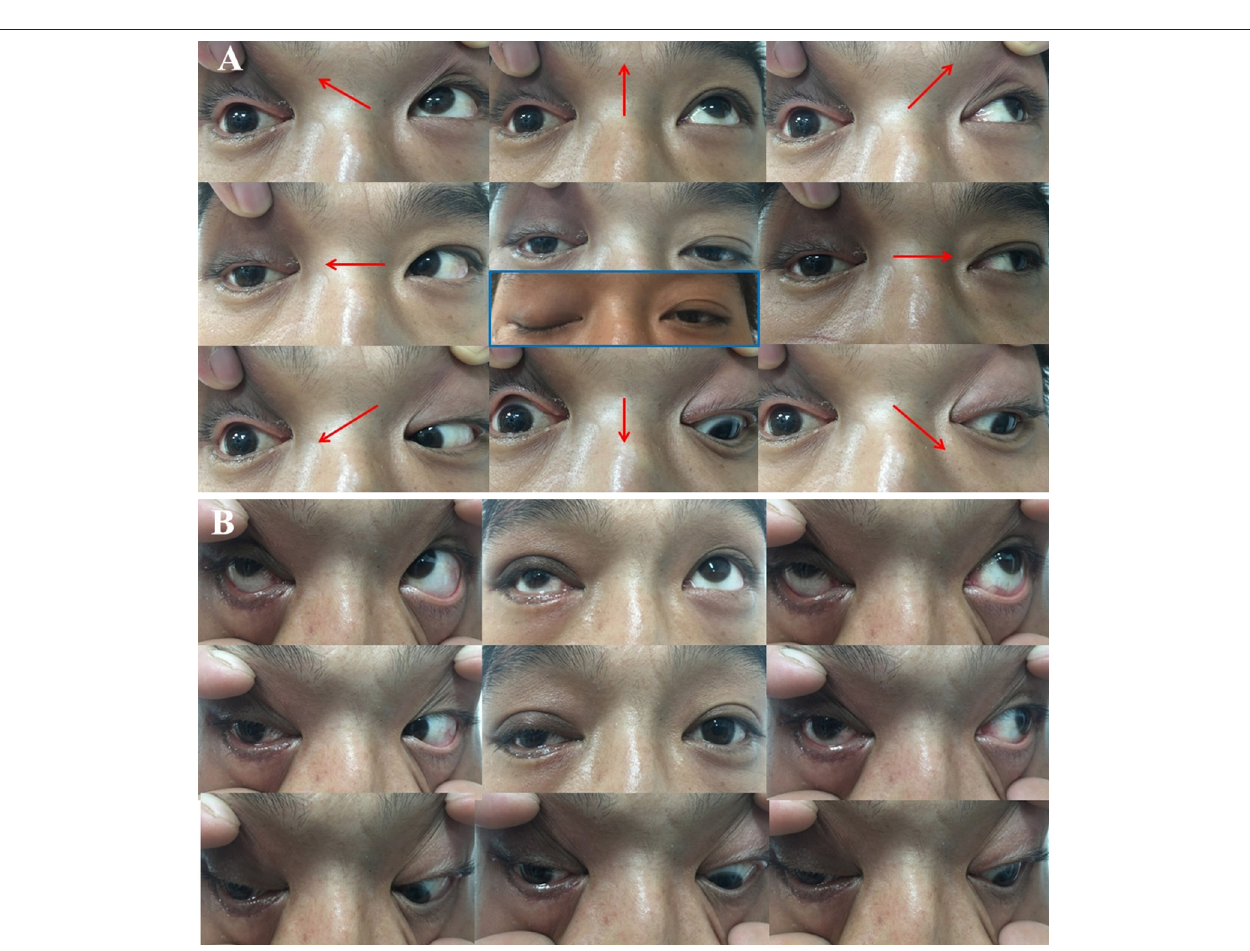
FIGURE 4 | Photographs of gaze positions in nine directions before (A) and 3 weeks after (B) surgery, namely, primary gaze (middle), elevation (top middle), depression (bottom middle), dextroversion (middle left), levoversion (middle right), dextroelevation (top left), dextrodepression (bottom left), levoelevation (top right), and levodepression (bottom right) views. (A) Complete ophthalmoplegia and ptosis were observed on the right side before surgery. (B) Partial recovery of ptosis, along with infraduction and adduction, was observed 3 weeks after surgery.